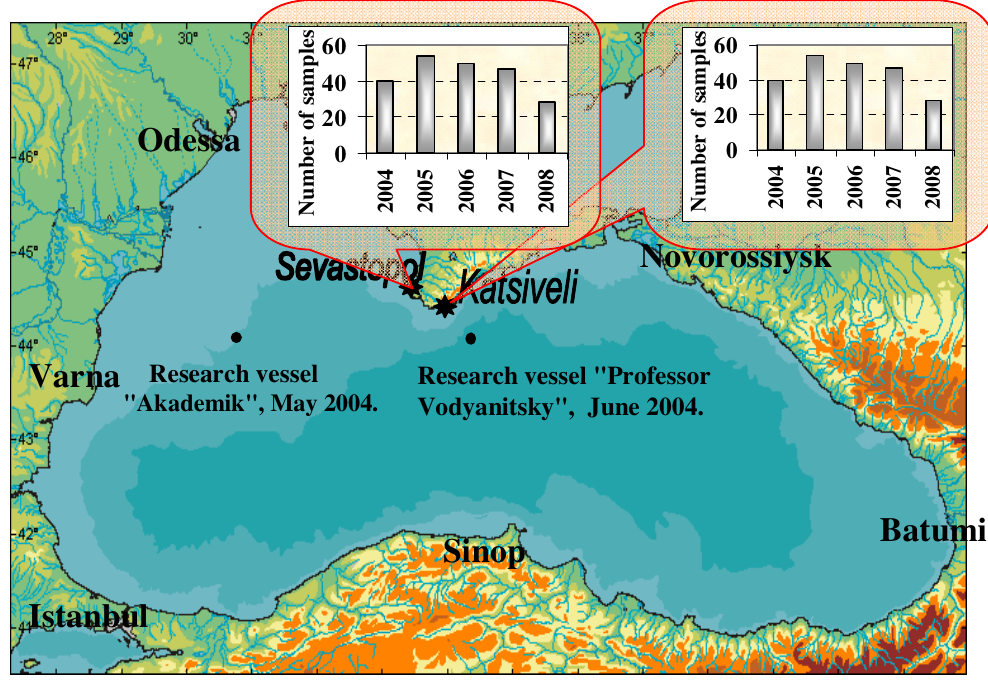
Figure 1. Monitoring sites in Sevastopol and Katsiveli ( ∗ ) and off-shore sampling locations ( • ). Data from off-shore locations and from Odessa have been used to verify the multiple regression